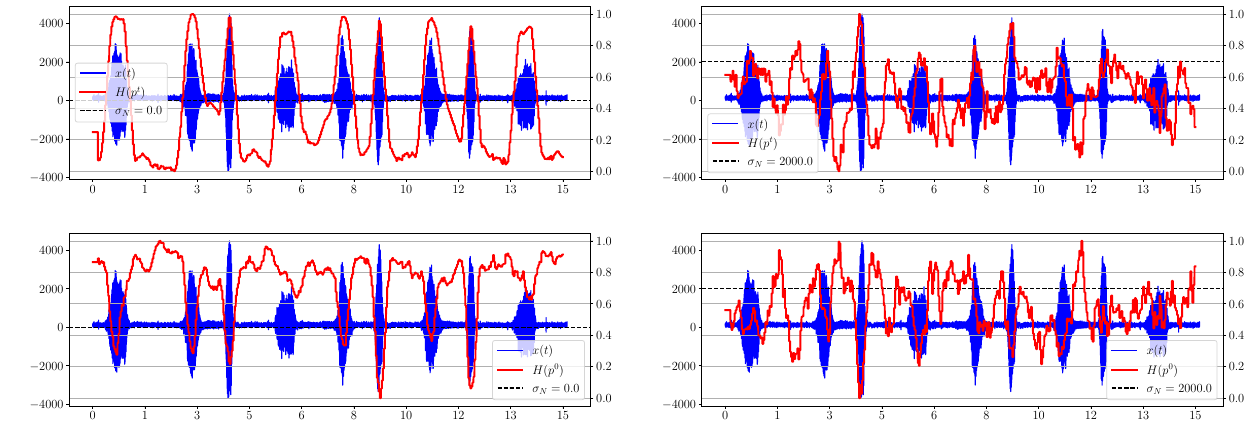
Figure 1. Graphs of H ( p t ) and H ( p 0 ) for different levels of added noise. The information characteristic LH ( pq ) stands out favorably from the time entropies, as demonstrated above.